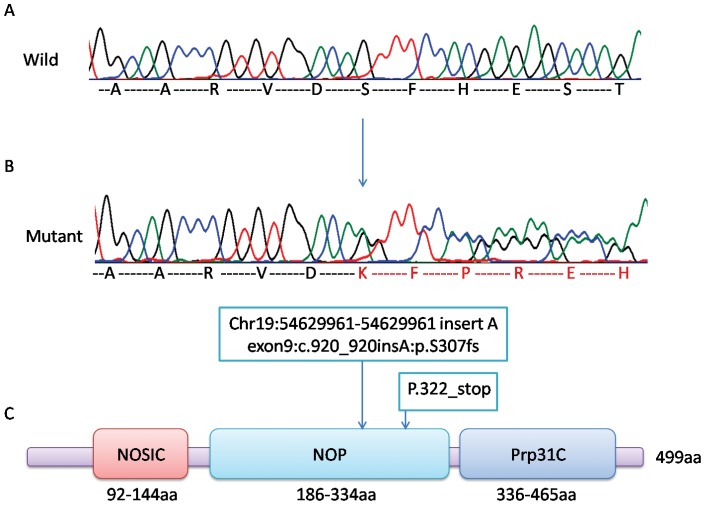
Detected mutation in the PRPF31 gene.A is the wild type sequence peak chart of the PRPF31 gene. B is the mutant type sequence peak chart of the PRPF31 gene: the heterozygous mutation that results in a single “A” nucleotide's insertion at chr19:54629961-54629961 (exon9, c.920_920insA). This insertion leads to the coding protein's frame shift at p.307 and early termination at p.322. C is the predicted PRPF31 protein's domains, showing that the mutation is in the functional domain NOP, whichis essential for U4/U6-U5 tri-snRNP formation.